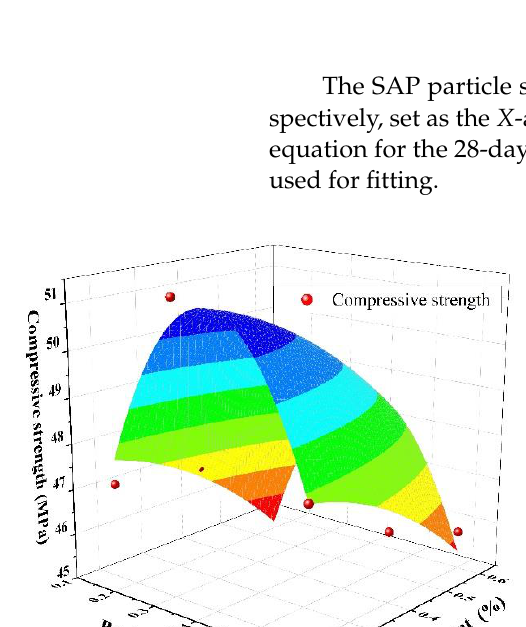
Figure 3. Concrete compressive strength under different water–cement ratios: ( a ) water–cement ratio of 0.3; ( b ) water– cement ratio of 0.37.